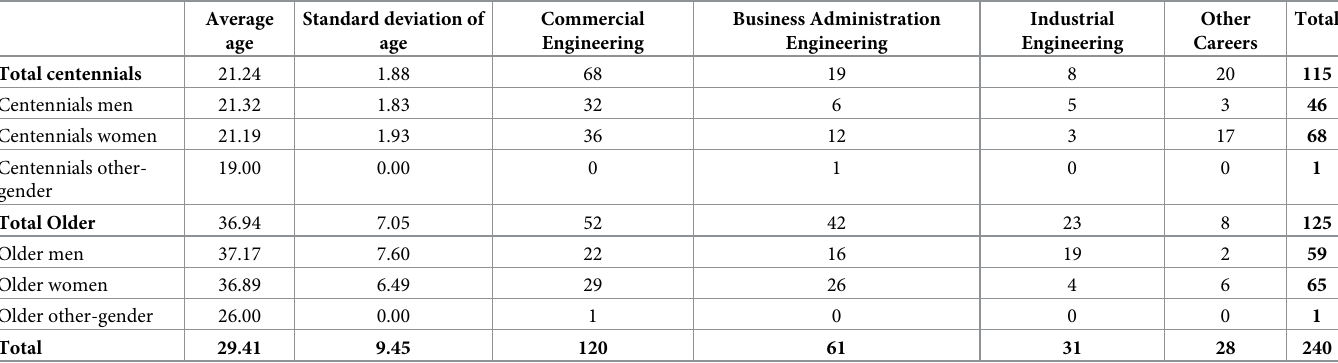
Table 1. Description of the